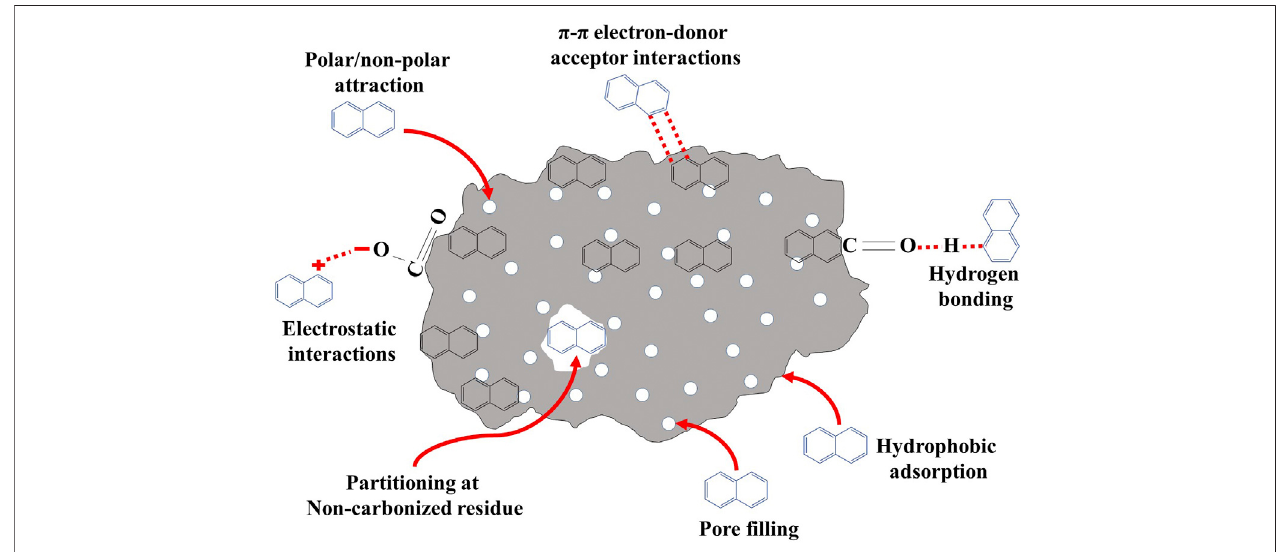
FIGURE 2 | Mechanisms involved for the adsorption of atrazine onto